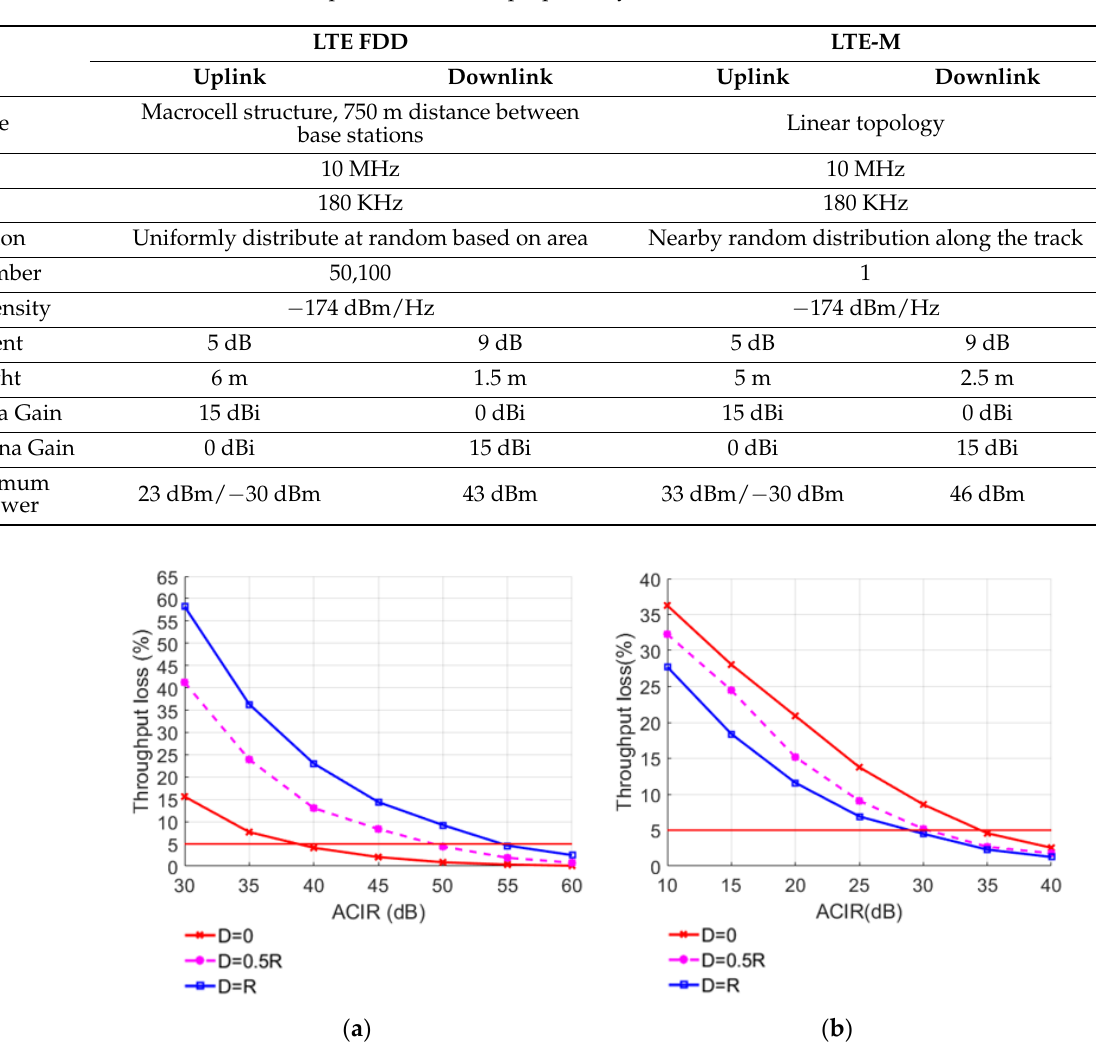
Table 10. Simulation parameters of the proposed system.